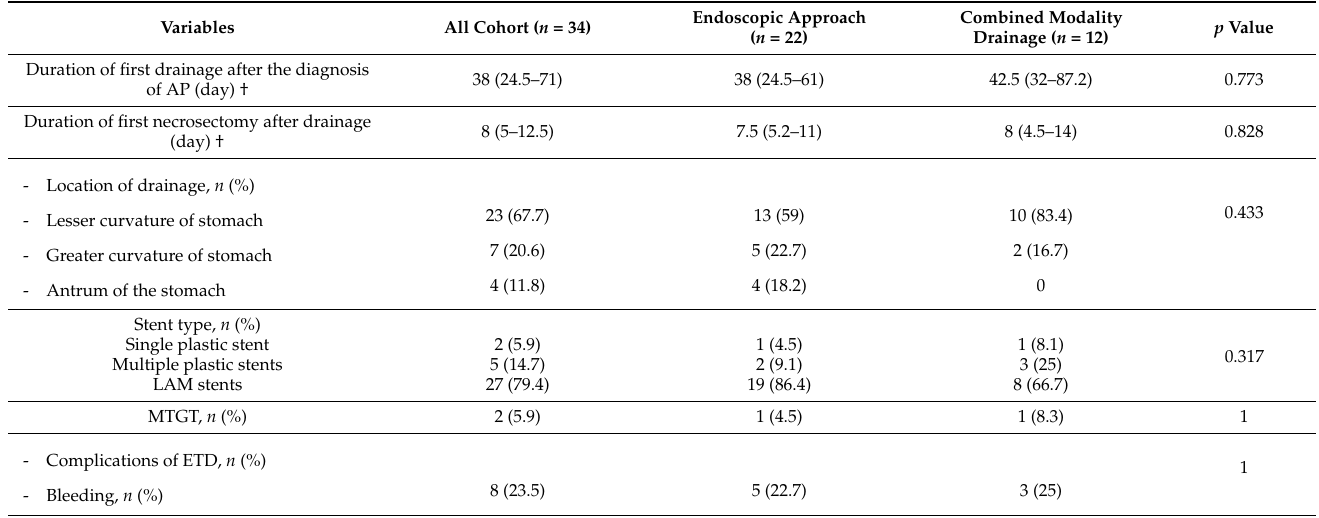
Table 3. Procedure techniques and adverse